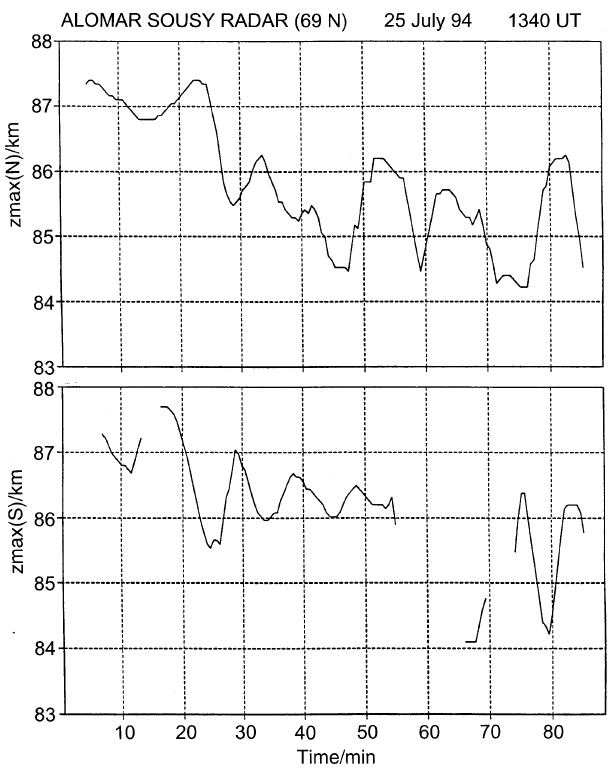
Fig. 6. Temporal variation of the height of the echo power max- imum observed in the northward ( upper part ) and the southward ( lower part ) directed beam for the 90-min observational period, starting at 1340